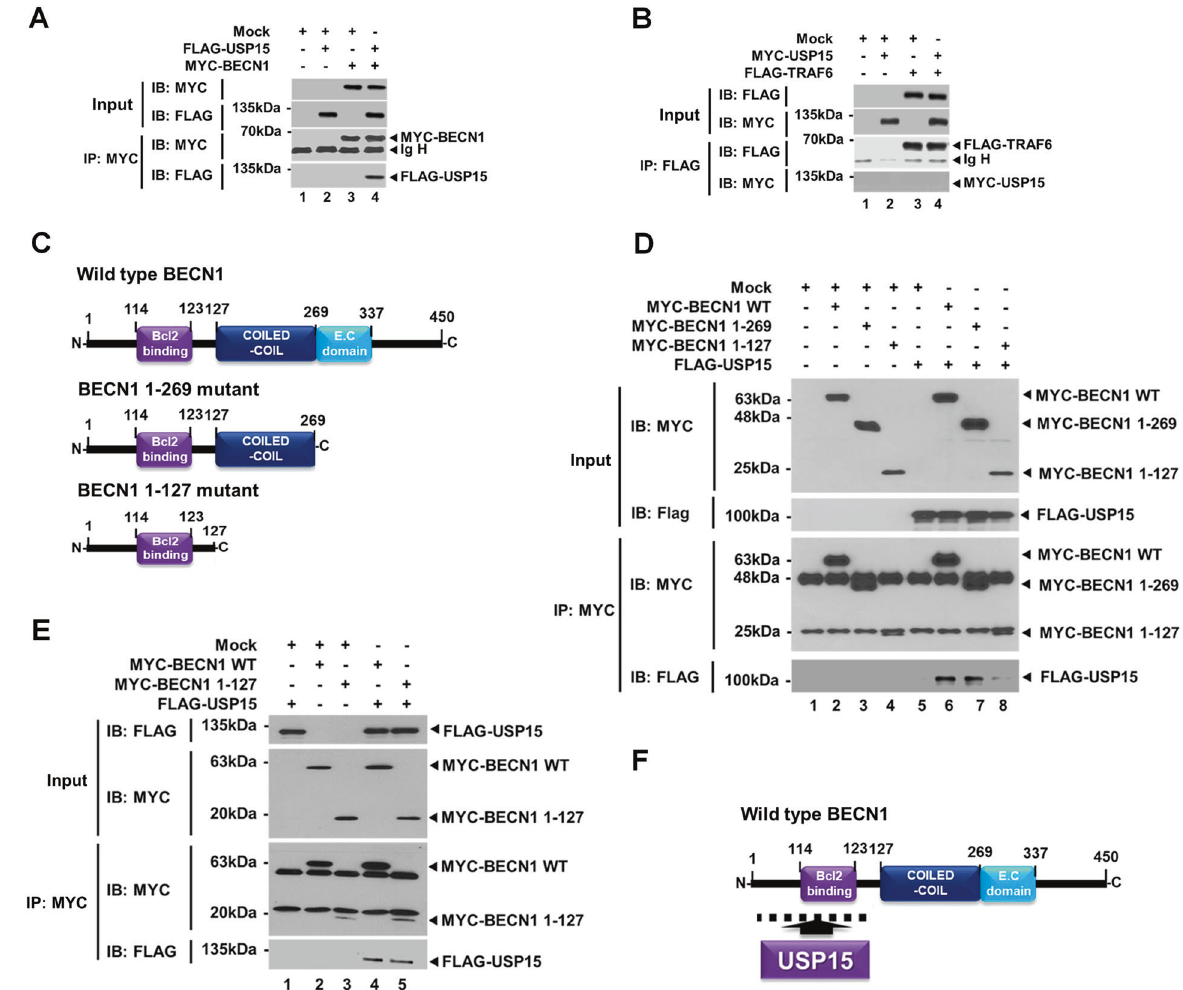
antibody. B IP assay was performed with anti-FLAG antibody using HEK 293 T cells transfected with mock, MYC-USP15, and FLAG-TRAF6 as indicated. IB assay was performed with anti-FLAG or anti-MYC antibody. C Truncated mutants of BECN1, BECN1 1-269, and BECN1 1-127 mutants were generated as described in “ Materials and methods ” . D IP assay was performed with anti-MYC antibody using HEK 293T cells transfected with mock, MYC-BECN1 wild-type (WT), MYC-BECN1 1-269, MYC-BECN1 1-127, and FLAG-USP15 as indicated. IB assay was performed with anti-FLAG or anti-MYC antibodies. E IP assay was performed with anti-MYC antibody using HEK 293T cells transfected with mock, MYC-BECN1 wild-type WT, MYC-BECN1 1-127, and FLAG-USP15, as indicated. IB assay was performed with anti-FLAG or anti-MYC antibody. F A schematic model for the interaction between BECN1 and